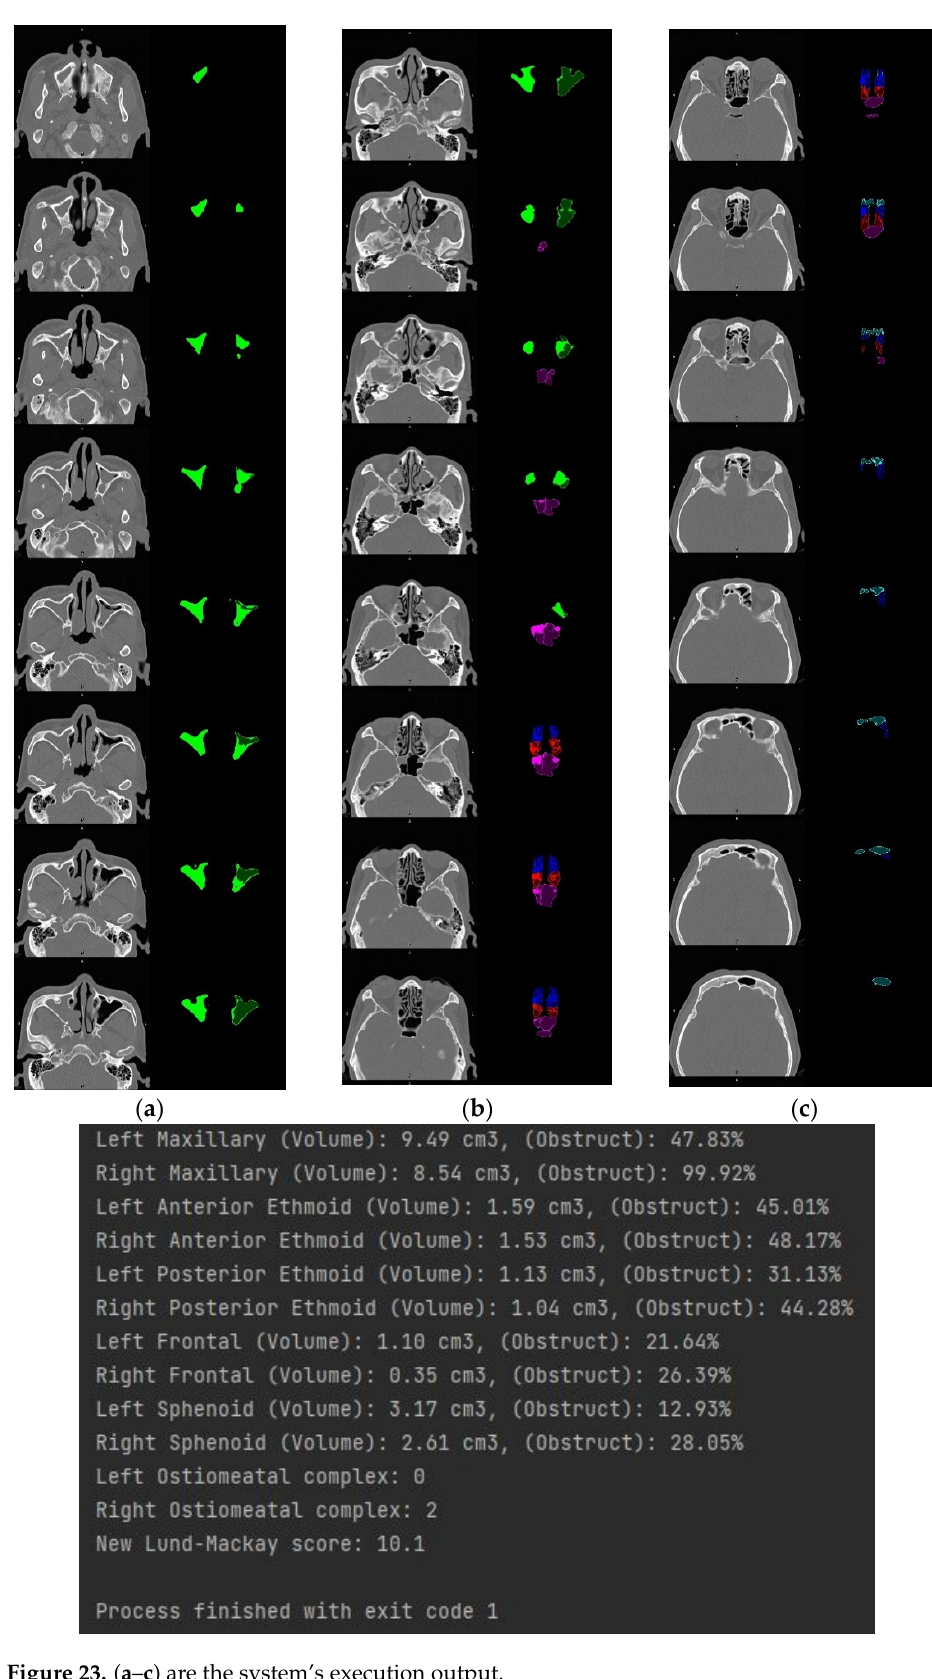
Figure 23. ( a – c ) are the system’s execution output.